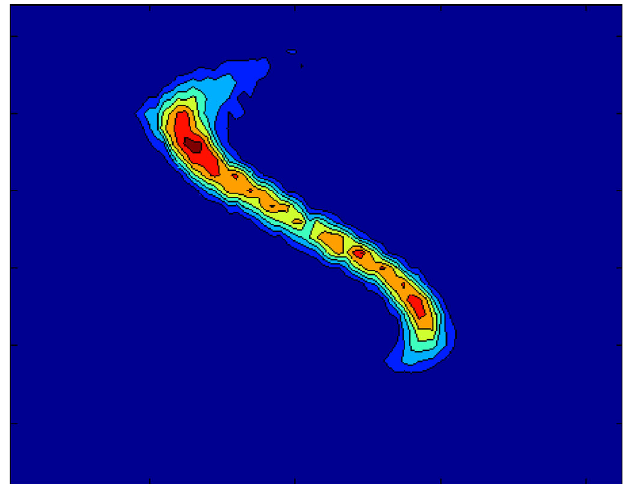
FIG. 2. (Color) Digitized image from the synchrotron light